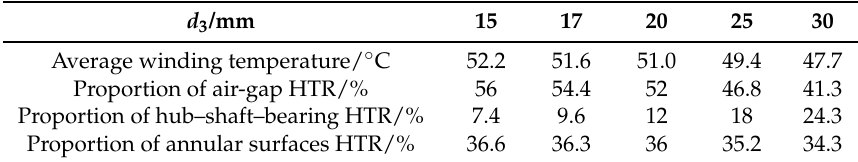
Table 6. Influence of d 3 on the temperature and HTR proportion.